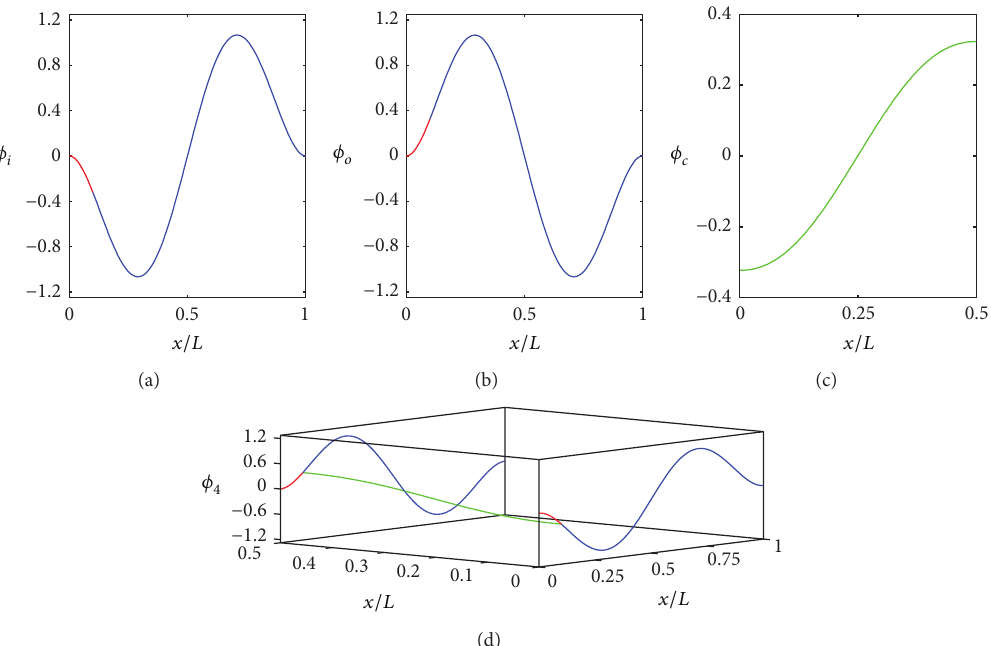
Figure 5: Fourth mode shape of the filter: (a) input, (b) output, (c) coupling beams, and (d) combination of (a), (b), and (c).